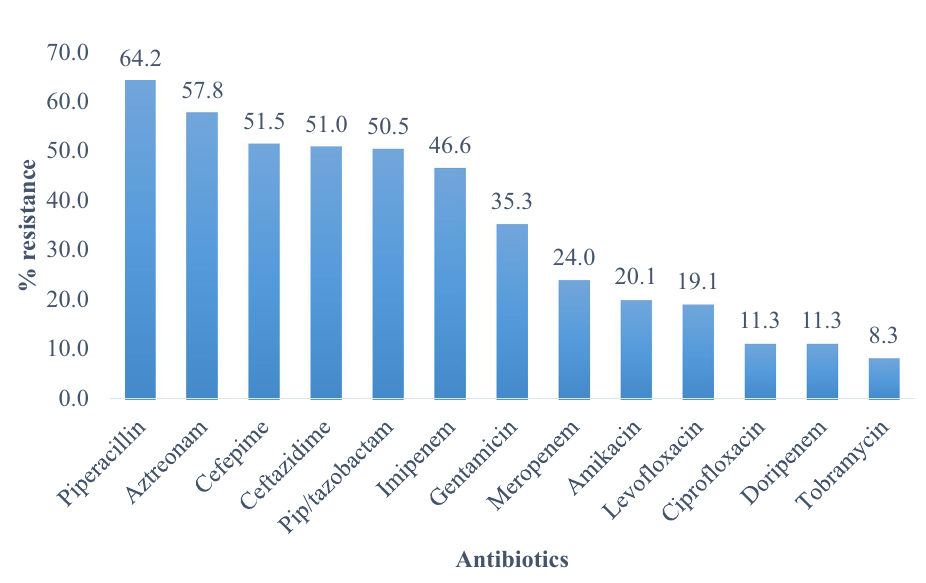
Figure 1. Antibiotic resistance pattern of the P. aeruginosa isolates (N =